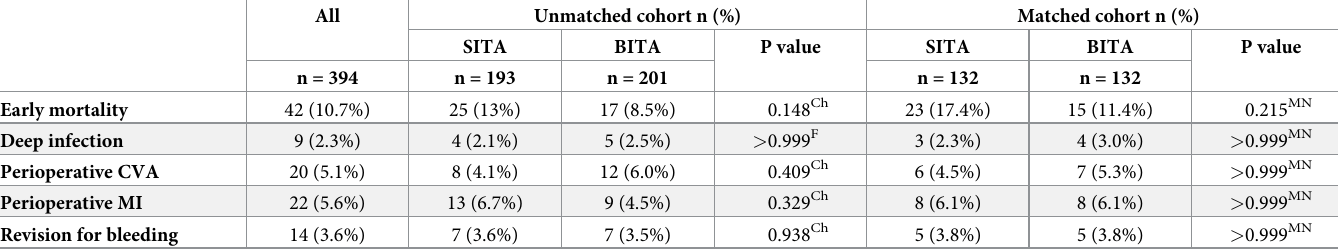
Table 2. Early outcomes of SITA and BITA grafting revascularizations in critical patients—Unmatched and matched cohorts.